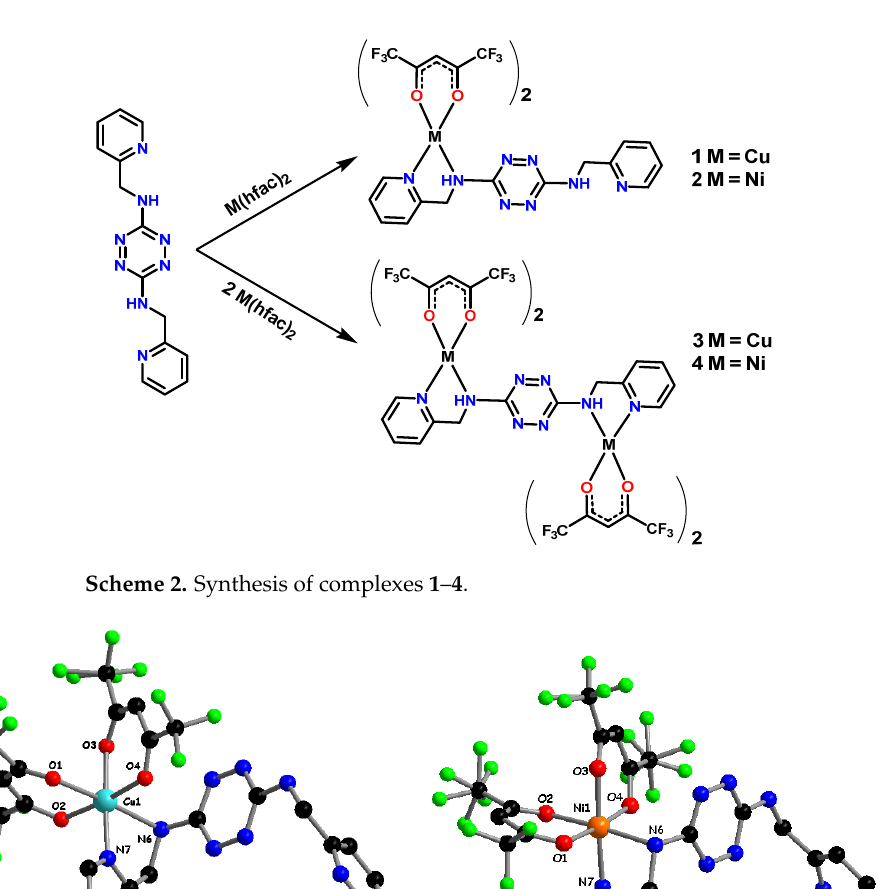
Figure 1. Crystal structures of 1 ( left ) and 2 ( right ) together with a partial atom numbering scheme. Some of the F atoms are disordered. Hydrogen atoms were omitted for clarity.